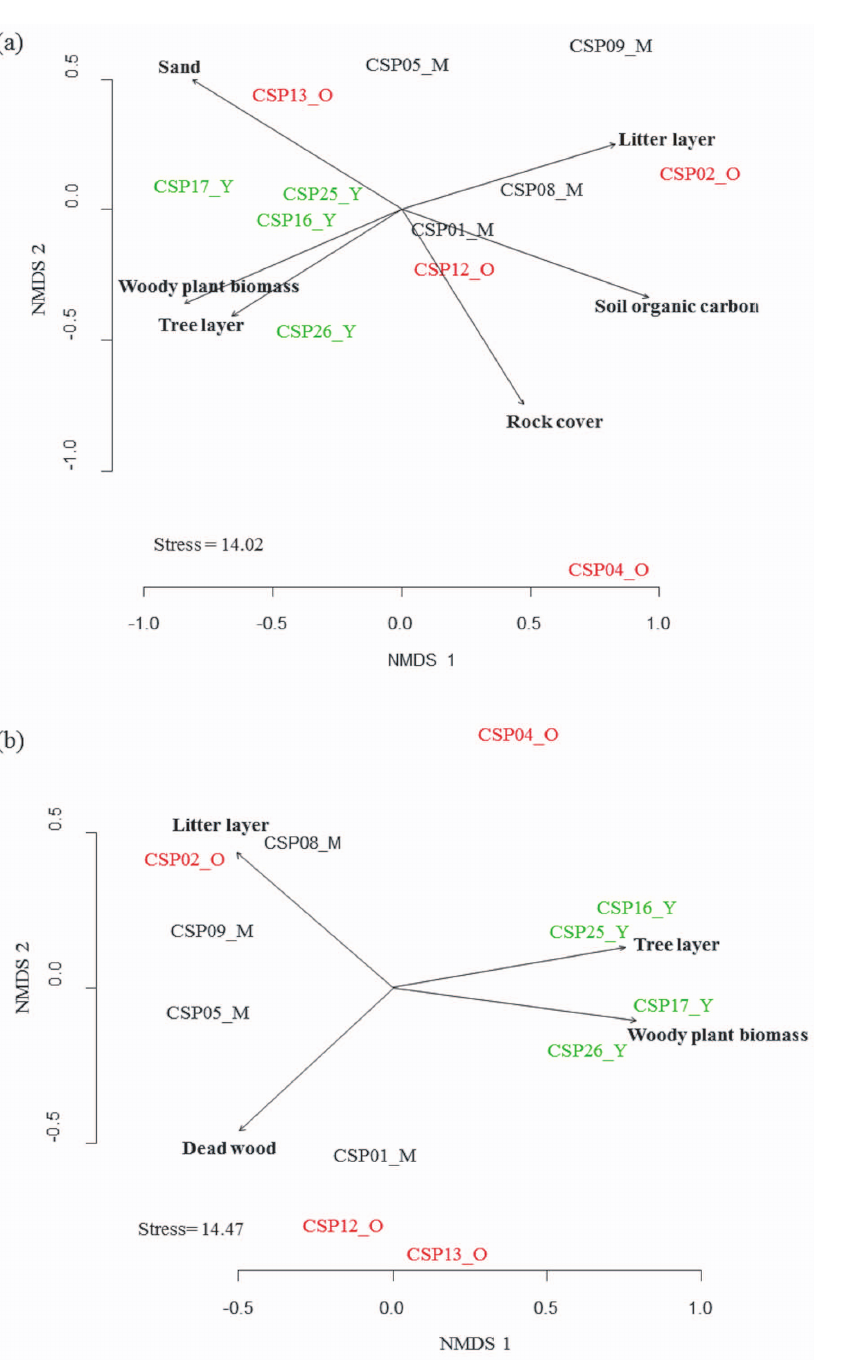
Figure 2. Distribution of observed richness of ECM fungal communities at the family (a) and OTU level of the most abundant ECM fungal family Russulaceae (b) across the three forest age classes visualized by heatmap.